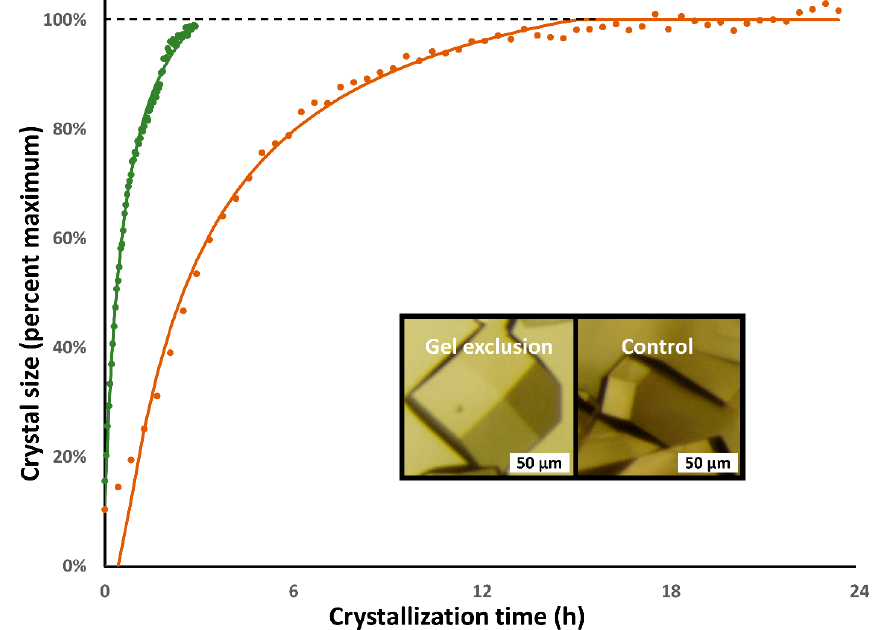
Figure 2. Growth rate for lysozyme crystals grown using gel exclusion (green) and conventional hanging drop (orange). Data are fitted by a single polynomial asymptotic curve with an upper bound that is lower than the asymptotic value. Crystal habits were similar